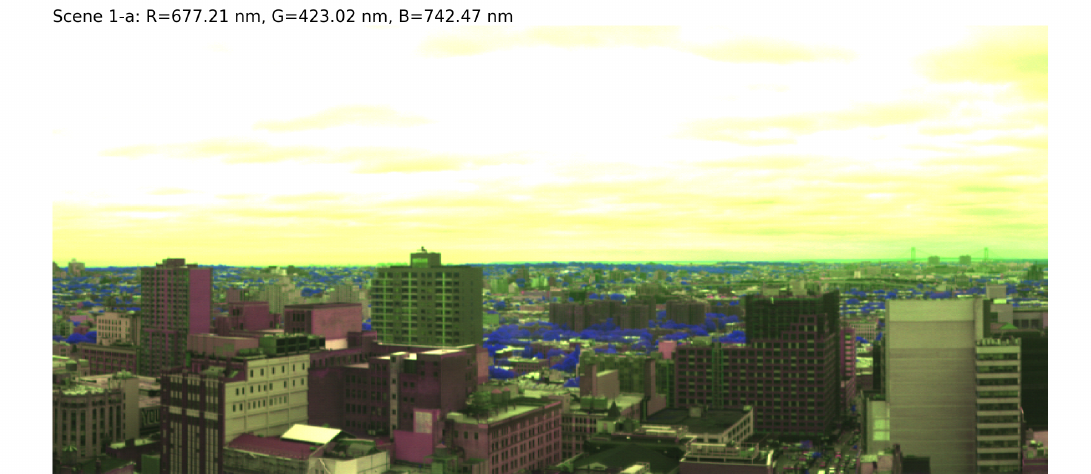
Figure 2. A false-color image of Scene 1-a from Figure 1 for which the color mappings of the RGB channels are chosen to differentiate several natural and human-built materials in the scene. In particular, the blue channel is mapped to ∼ 740 nm, a wavelength for which vegetation has a strong peak, and the vegetation pixels appear predominantly blue in this false-color representation. Built structures with peaks at other wavelengths that are mapped to the red and green channels are differentiated by the red and yellow tints of buildings in the